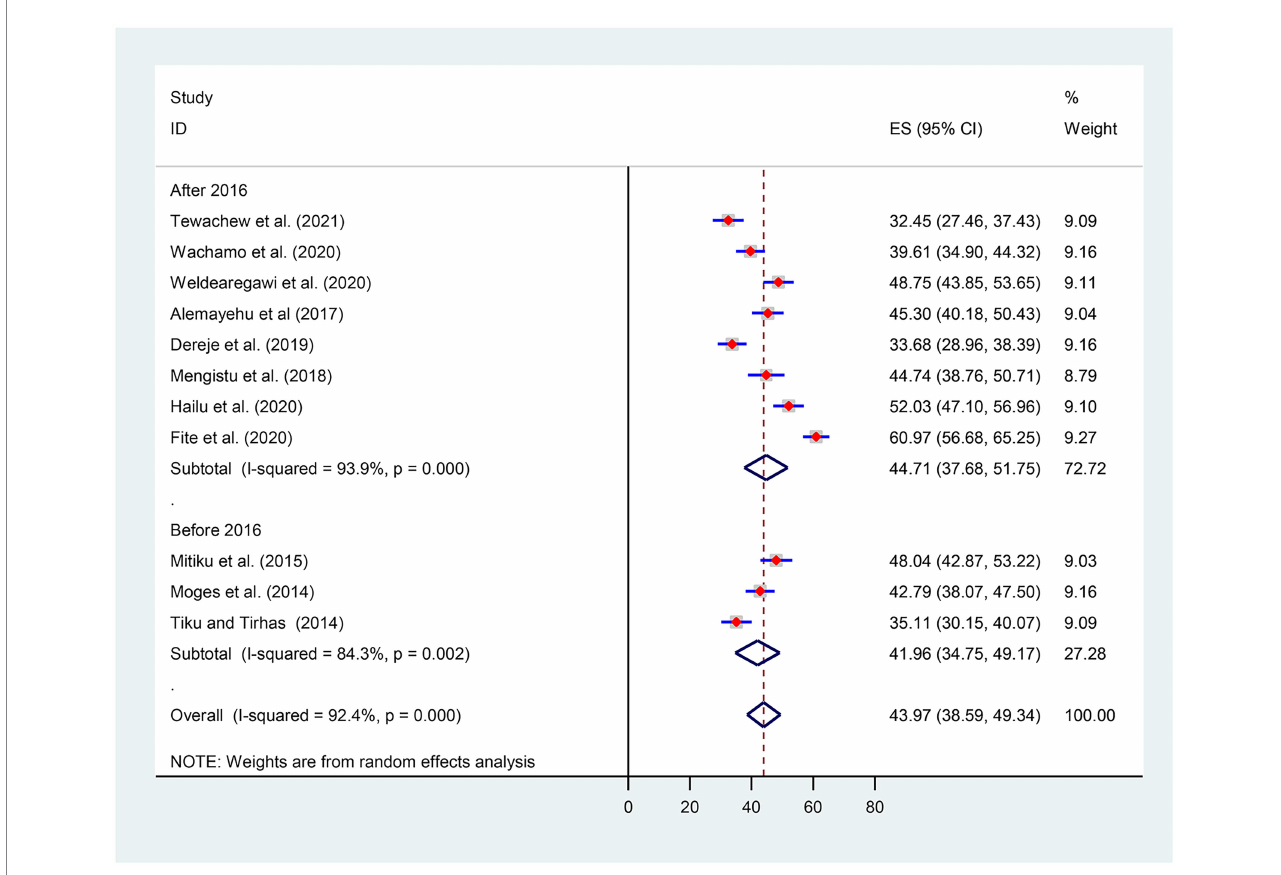
FIGURE 4 Subgroups analysis for the prevalence of OIs by year of